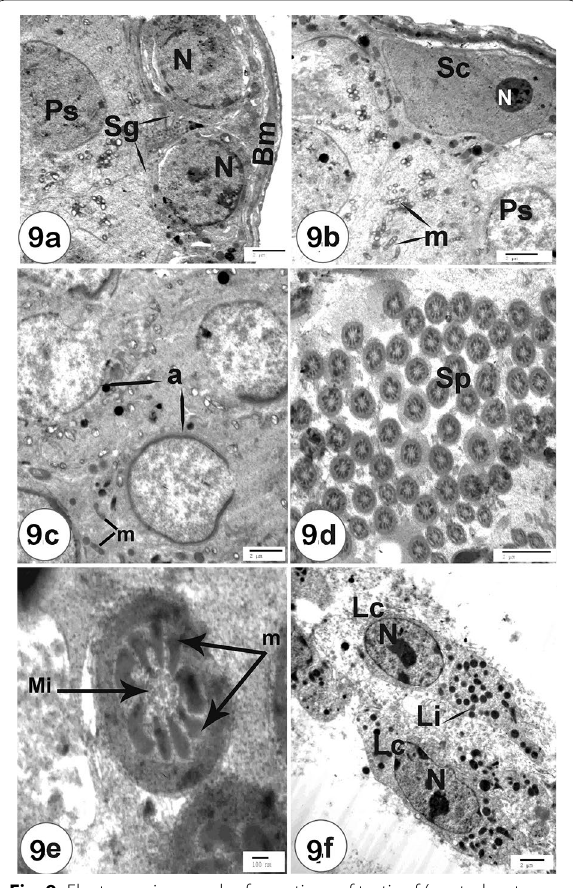
Fig. 9 Electron micrograph of a sections of testis of (control water, corn oil and quercetin) rats showing ( a ) basal lamina (Bm) of seminiferous tubules and spermatogonia (Sg) (Scale bar 2 µm), = b Sertoli cells (Sc) having triangular nucleus and primary spermatocytes (Ps) having mitochondria (M) and large spherical nuclei (Scale bar 2 µm), c spermatids (Sd) with spherical nucleus, = Note the differentiated part of acrosome ( a ) (Scale bar 2 µm), d = cross section of sperms’ tails (Sp) at the level of mid piece (Scale bar 2 µm), e higher magnification of d showing cross section of a = spermatozoan (Sp) at the mid piece containing 9 mitochondria (M) and microtubules (Mi) (Scale bar 100 nm) and f Leydig cell (Lc) with = normal nucleus (N) and marked increase in lipid droplets (Li) (Scale bar 2 =